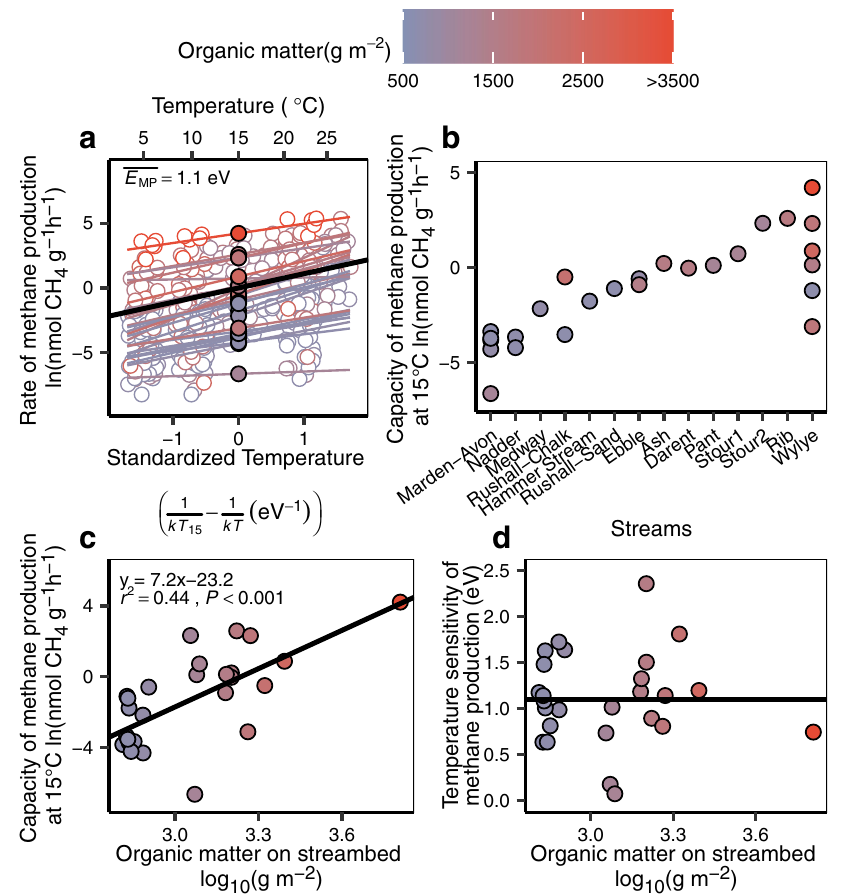
Fig. 2 Effect of organic matter on both the capacity and temperature sensitivity of streambed sediments to produce methane ( n = 371 observations in 14 streams). a Plotting natural-log-transformed methane production against standardized temperature demonstrated a similar temperature sensitivity across all our streams and an average, overall sensitivity ( E MP ), of 1.1eV (black solid line, 95% CI: 0.89 – 1.31). Filled circles represent the intercepts, i.e., the capacity of a sediment to produce methane standardized to 15°C in each stream and the color represents the organic matter content of the sediment (gm − 2 ). b In contrast to the consistency in temperature sensitivity, the capacity of streambed sediments to produce methane (at 15°C) varied by four orders of magnitude from 0.001 to 68 nmol CH 4 g − 1 h − 1 across our streams. c Methane production capacity (intercepts from panel a ) is positively correlated with organic matter on streambeds ( t -statistic, P <0.001). d There was no relationship between the temperature sensitivity (slopes from panel a ) of methane production and organic matter on streambeds ( t -statistic, P = 0.99). The horizontal solid line represents the average temperature sensitivity of methane production in streams, i.e., 1.1eV (95% CI: 0.45 – 1.75), in agreement with panel a . Therefore, while the temperature sensitivity of methane production was conserved, the potential for organic matter to exert variable and strong control over methane production was